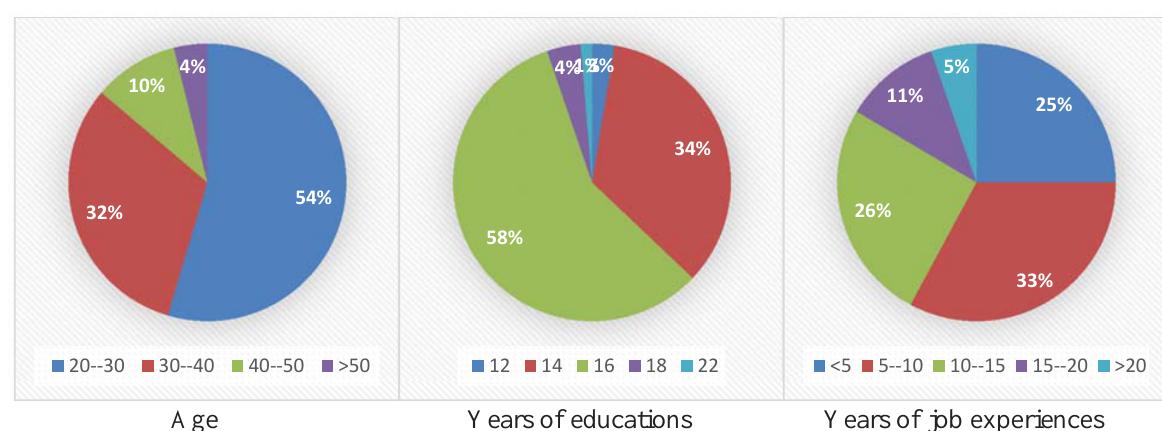
Fig. 2. Personal characteristics of the